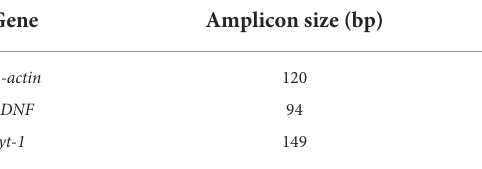
TABLE 1 Primer sequences used in